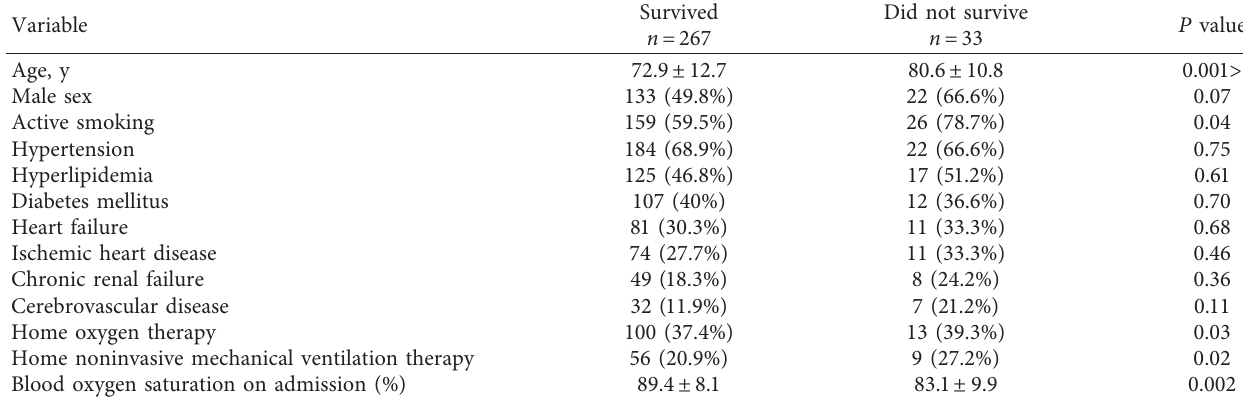
Figure 1: Flowchart presenting the study design. Table 1: Baseline characteristics of patients with chronic obstructive pulmonary disease (COPD) according to survival during hospi- talization for exacerbated